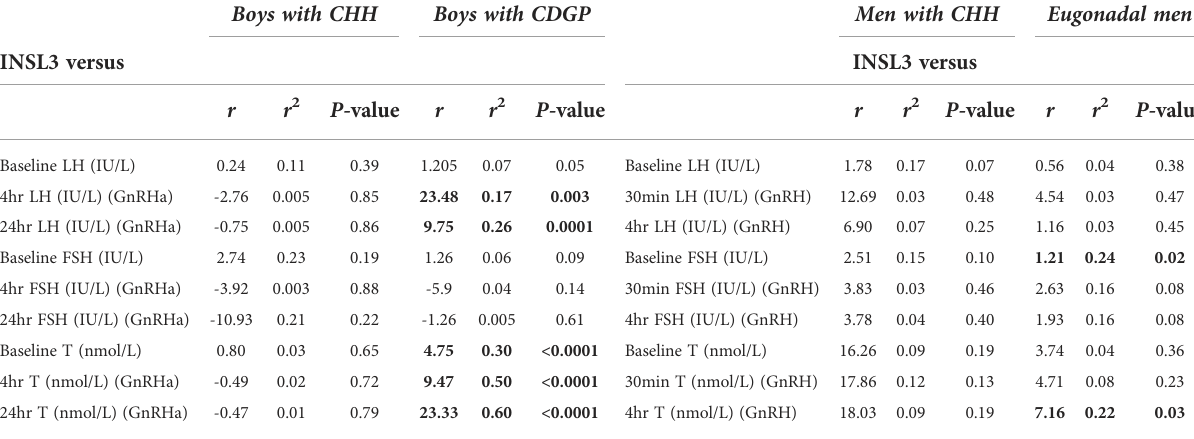
TABLE 1 Linear regression analysis of INSL3 vs baseline and stimulated LH, FSH, testosterone in the delayed puberty and adult cohorts. Boys with CHH Boys with CDGP Men with CHH Eugonadal men INSL3 versus INSL3 versus r r 2 P -value r r 2